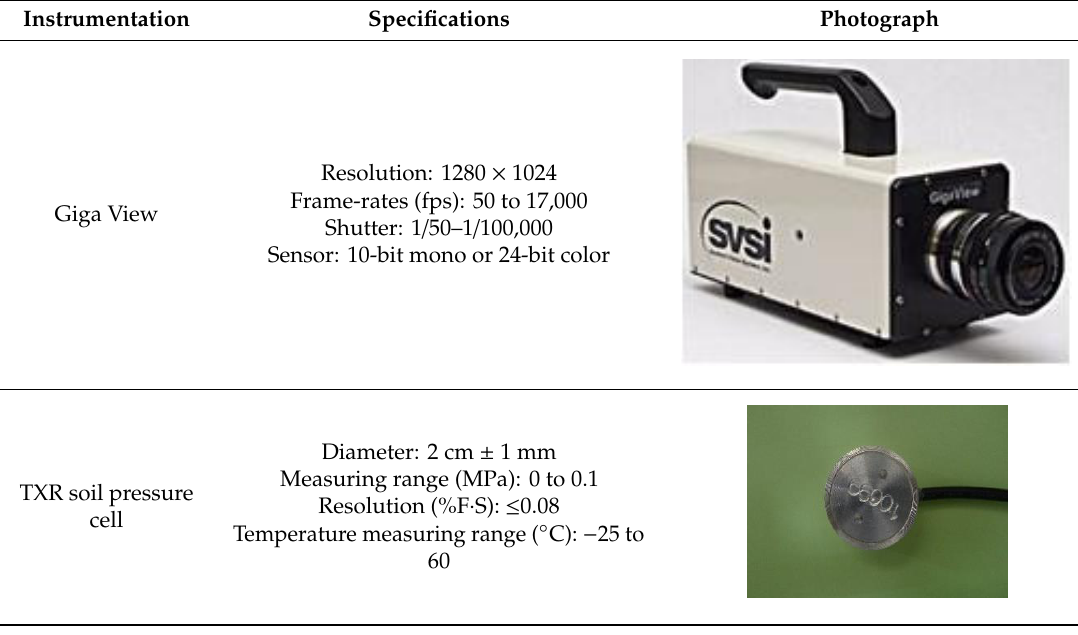
he instrumentation monitoring units.